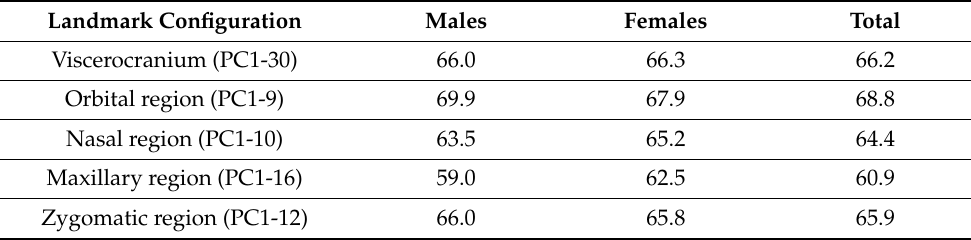
Table 4. Classification accuracy (in %) based on the shape variables. Landmark